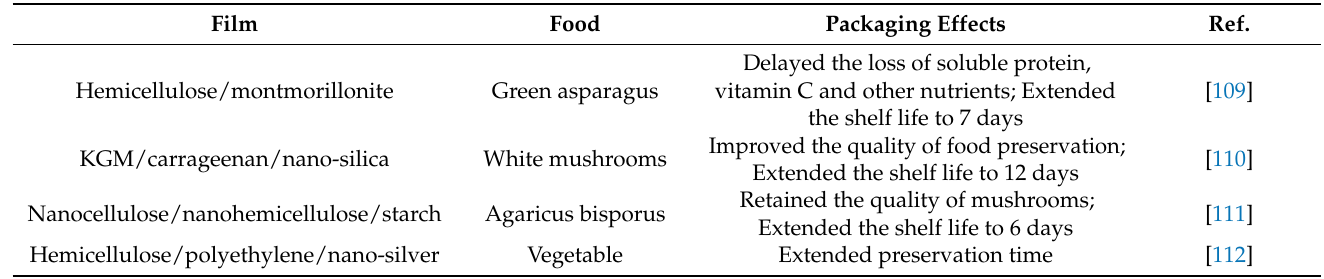
Table 4. Application of hemicellulose-based nanocomposite film in food packaging.